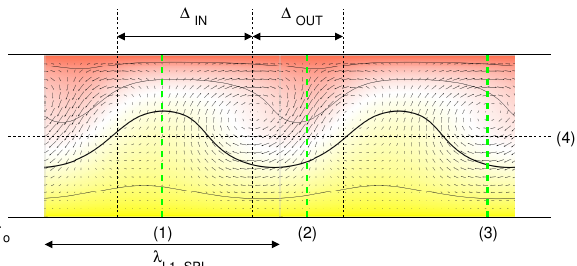
Figure 5. Schematics illustrating the main flow positions exemplarily shown on a L1-SPI ( Re = 0, α = 0): (1) inflow; (2) outflow; (3) vortex core; (4) mid-gap; ∆ IN [ OUT ] regime of inflow [outflow] ( r = 0.5); r i [ o ] : inner [outer] cylinder